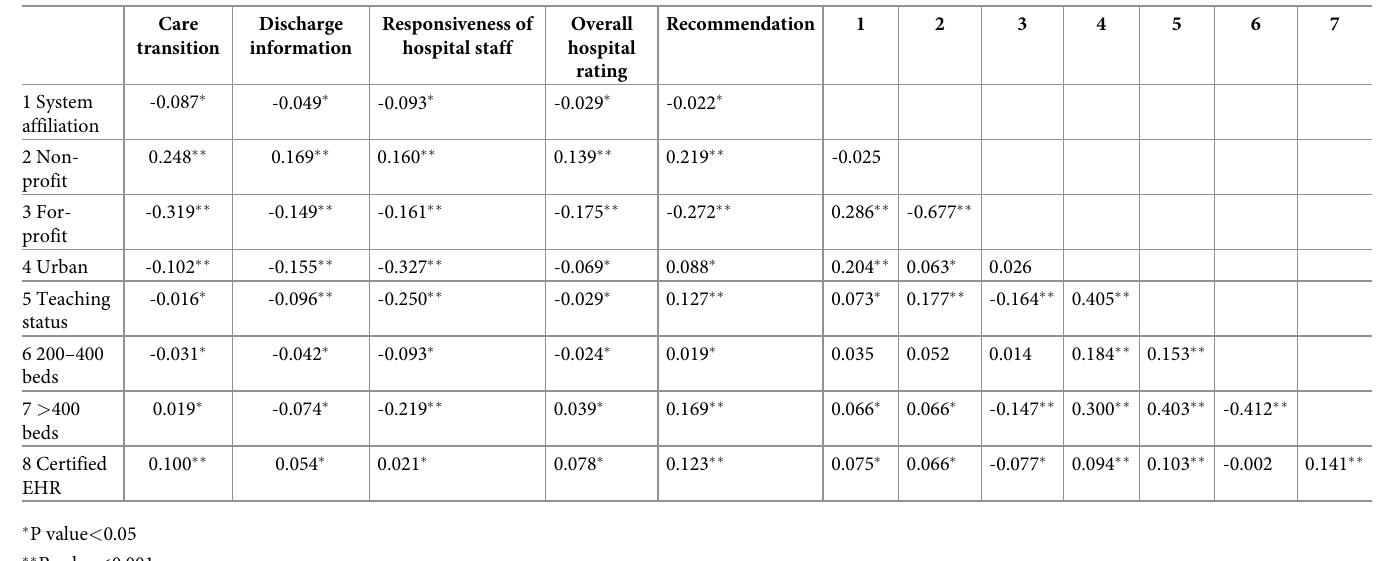
Table 2. Correlations between Hospital characteristics and EHR status.